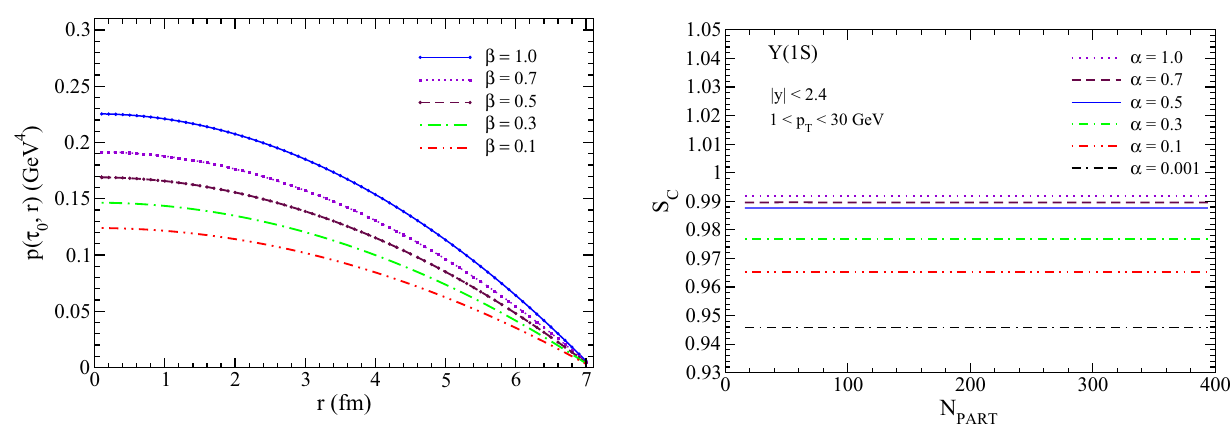
Fig. 2 Pressure profile, p (τ 0 , r ) is plotted against the transverse dis- tance, r for various values of β Other parameters are defined as; c s is speed of sound in QGP medium, η is shear viscosity of medium and q = c 2